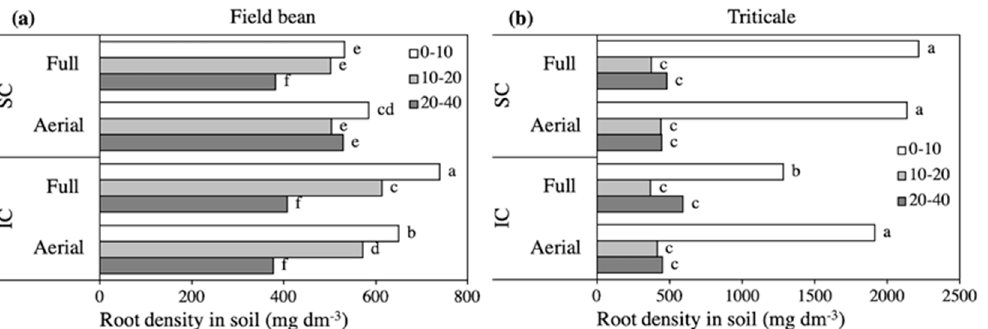
Figure 2. Root biomass density in soil of field bean ( a ) and triticale ( b ), as affected by the Crop system × Row contact × Soil depth interaction. SC, sole crop; IC, intercrop. Values are the mean of two nitrogen rates and three replicates. Within each figure, bars with different letters indicate that the corresponding means are significantly different at P < 0.05, Tukey’s test.